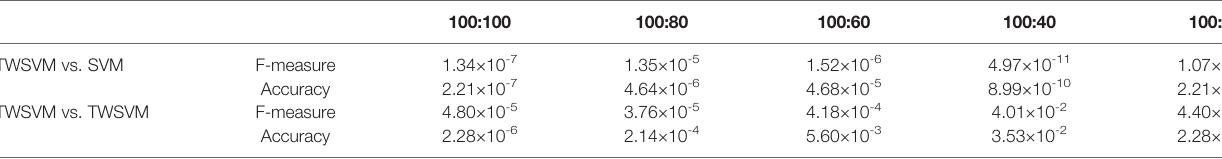
TABLE 2 | The p-values between the ITWSVM algorithm and classical SVM and TWSVM algorithms for various IR.